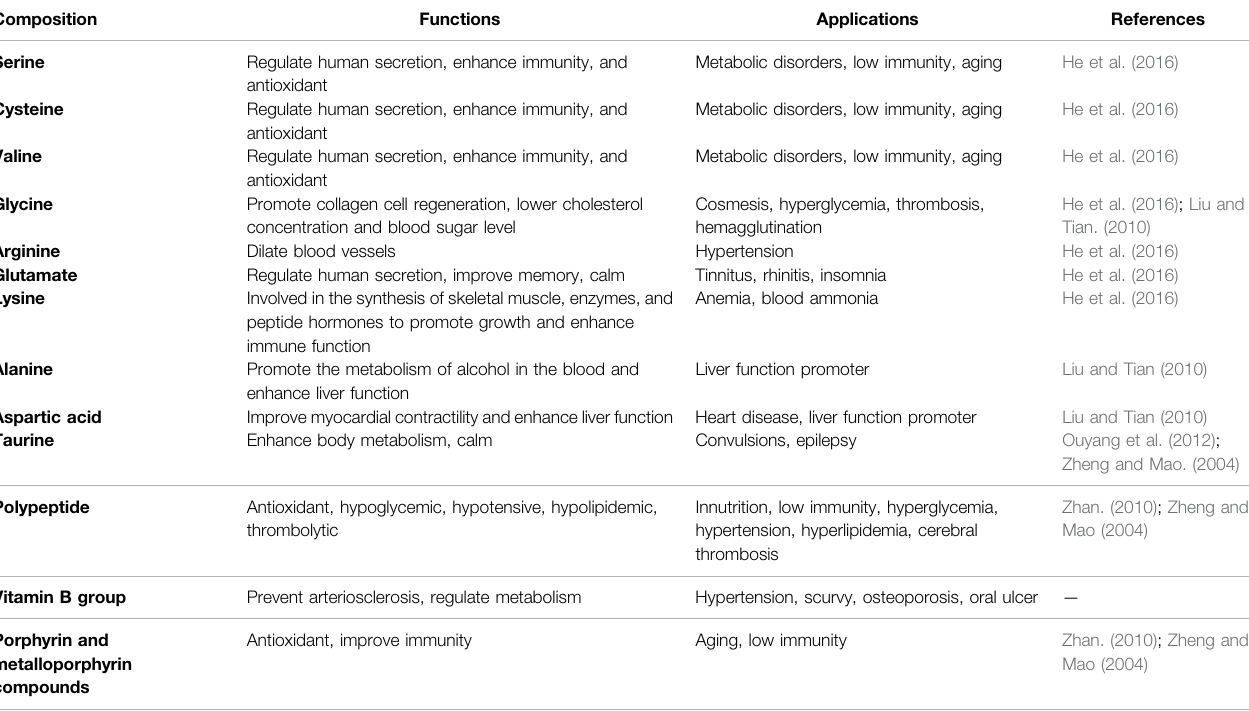
TABLE 5 | Functions and applications of organic components in